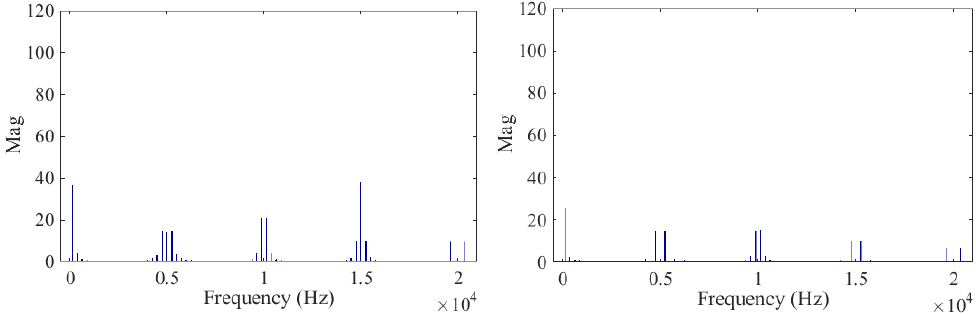
Figure 10. FFT analysis of CMV for DZICMV: ( left ) the sub-CMV V cm 1 ; ( right ) total CMV V cm . Table 8. The CMV maximum harmonic amplitudes for DZIPWM and